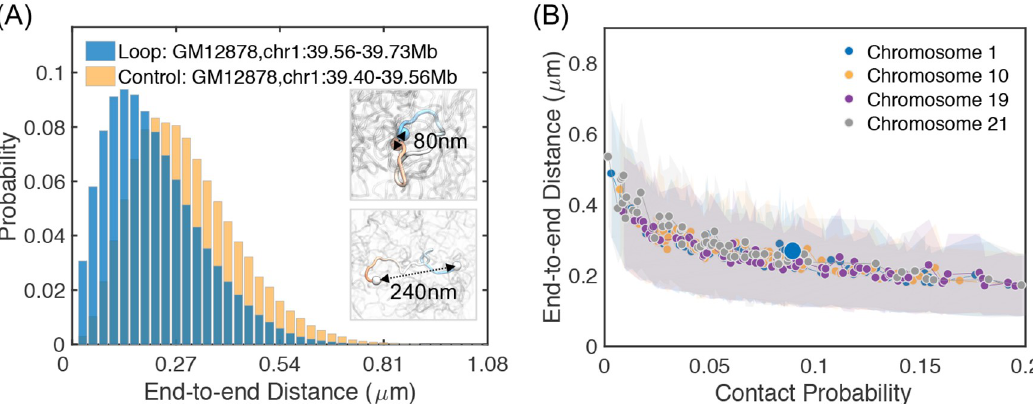
Fig 5. Structural characterization of chromatin loops. (A) Probability distribution of the end-to-end distance for the chromatin loop formed between chr1:39.56 Mb and chr1:39.73 Mb from GM12878 cells (blue) and for a random genomic pair (yellow). Two example configurations that correspond to open and closed chromatin loop structures are shown in the inset. (B) End-to-end distances of chromatin loops versus their corresponding contact probabilities. The shaded areas represent the variances in distances estimated from the simulated structural